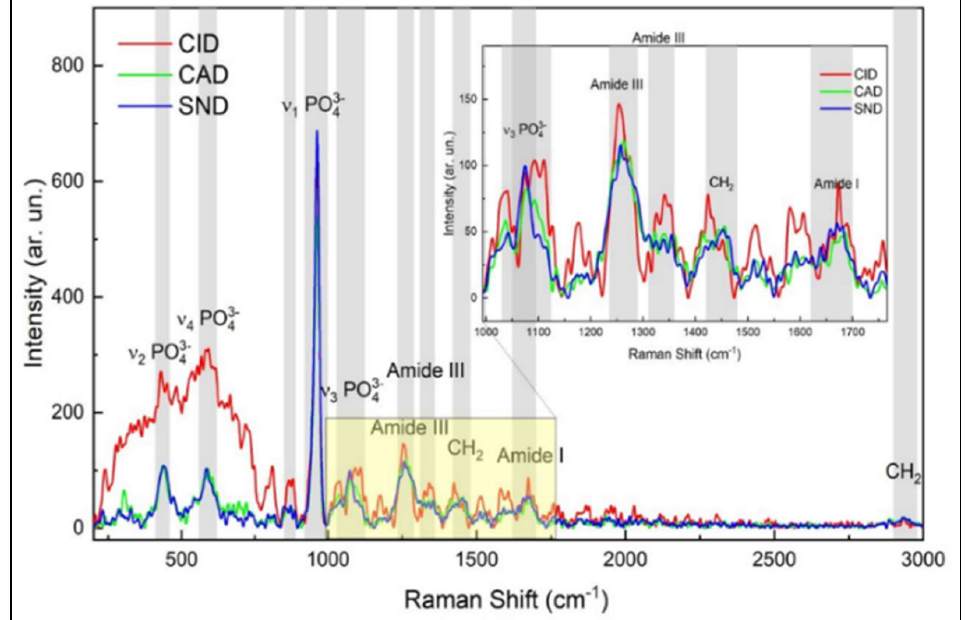
Figure 2. Representative Raman spectra of the caries-infected (CID), caries-affected (CAD) and sound dentin in the occlusal carious lesion. The spectra were normalized based on the peak intensities of v1-PO at 960 cm −1 , which is the strongest signal among all Raman spectra, it is the highest in sound dentin. Amide I at 1650 cm −1 , Amide III at 1235 cm −1 and C-H bond of the pyrrolidine ring at 1450 cm −1 are the highest in CID. The inserted figure shows the magnified, same spectra in the range from 1000 to 1700 cm −1 .